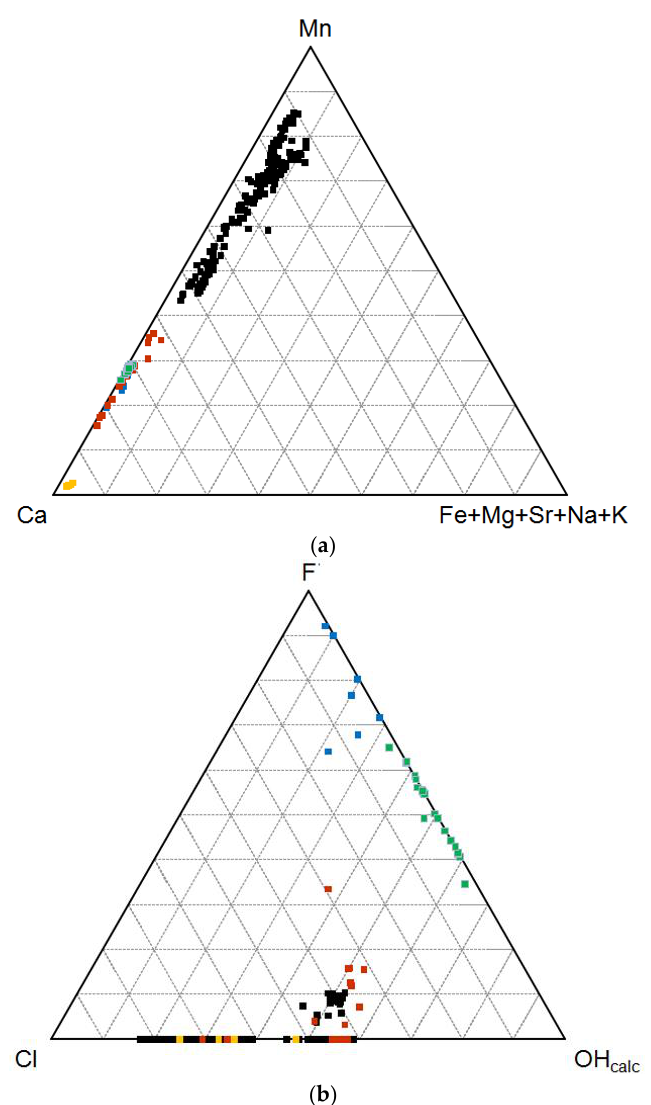
Figure 3. Chemical composition of Types 1–4 apatites from the Szklary pegmatite compared to common apatite from the same pegmatite (data from [8]) in the triangular diagrams: ( a ) Mn–Ca–∑(Fe + Mg + Sr + Na + K) and ( b ) F–Cl–OH cal . Colours: black—Type 1, red—Type 2, green—Type 3, yellow—Type 4, blue— common apatite .